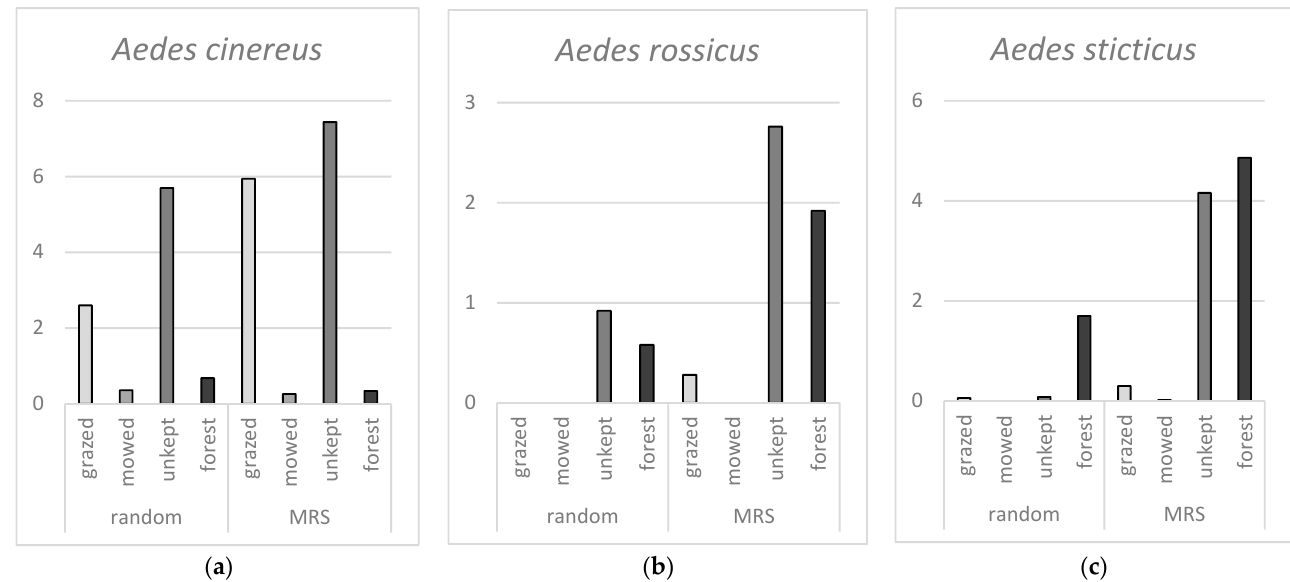
Figure 3. ( a ) Mean number of Ae. cinereus larvae hatched per sample in random and MRS samples from different environmental categories. ( b ) Mean number of Ae. rossicus larvae hatched per sample in random and MRS samples from different environmental categories. ( c ) Mean number of Ae. sticticus larvae hatched per sample in random and MRS samples from different environmental categories.